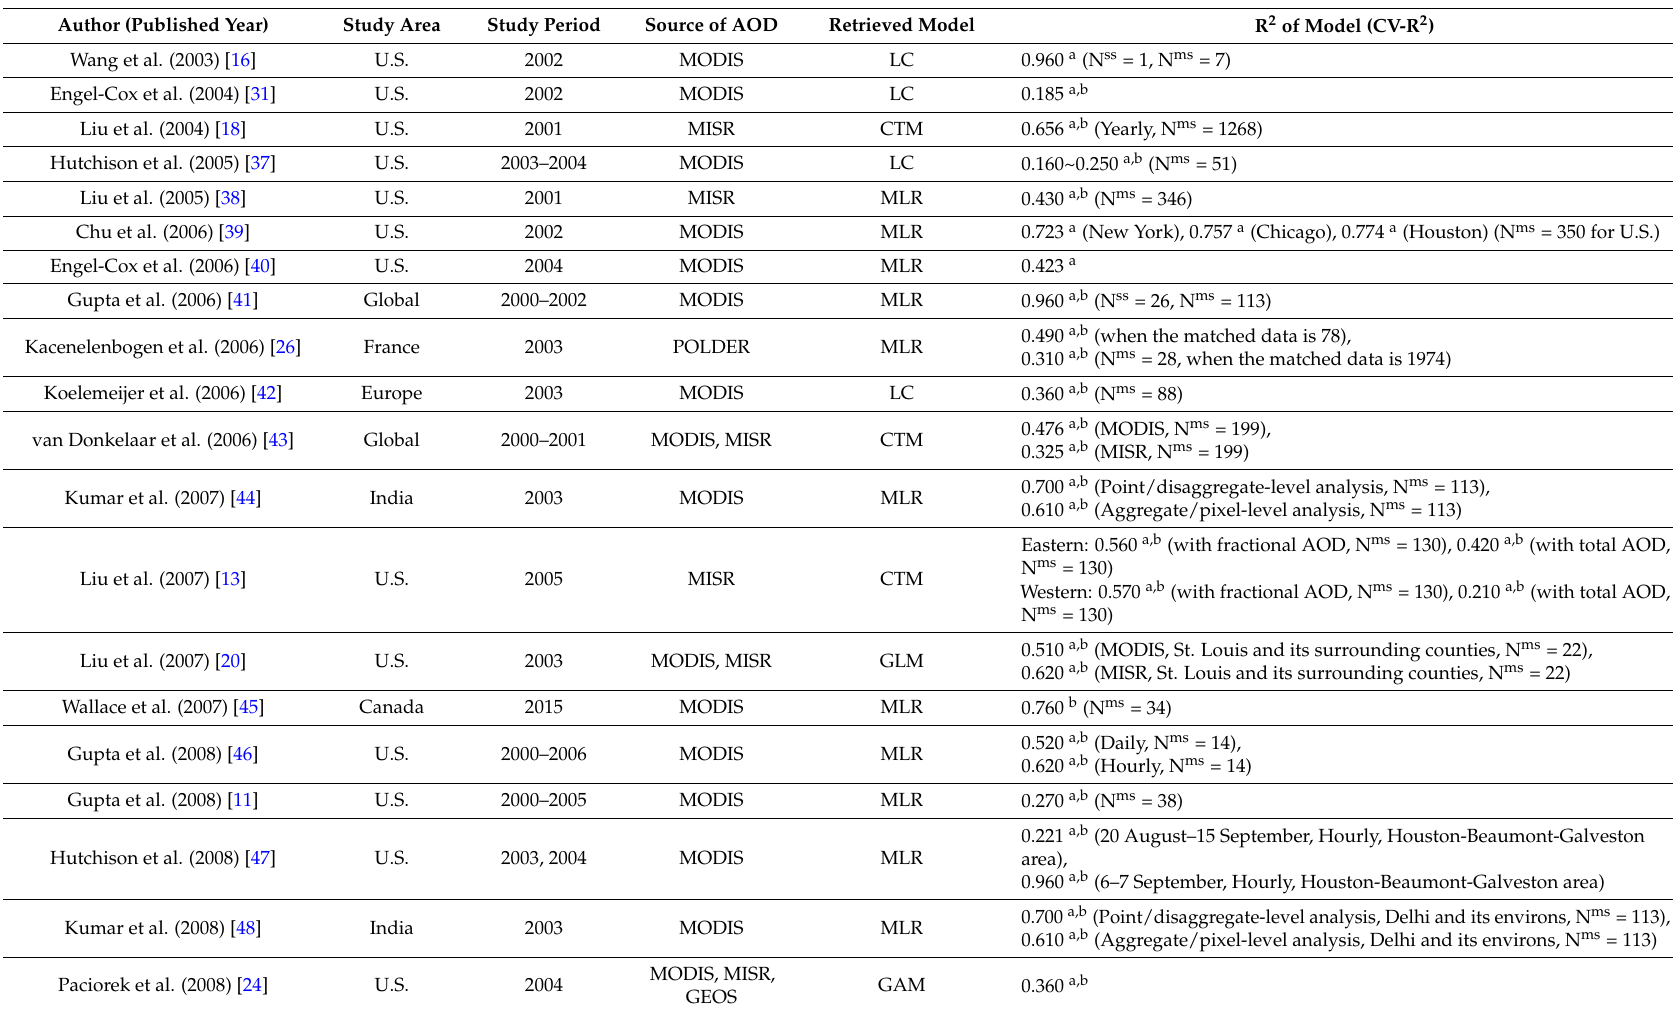
Table 1. Characteristics of included